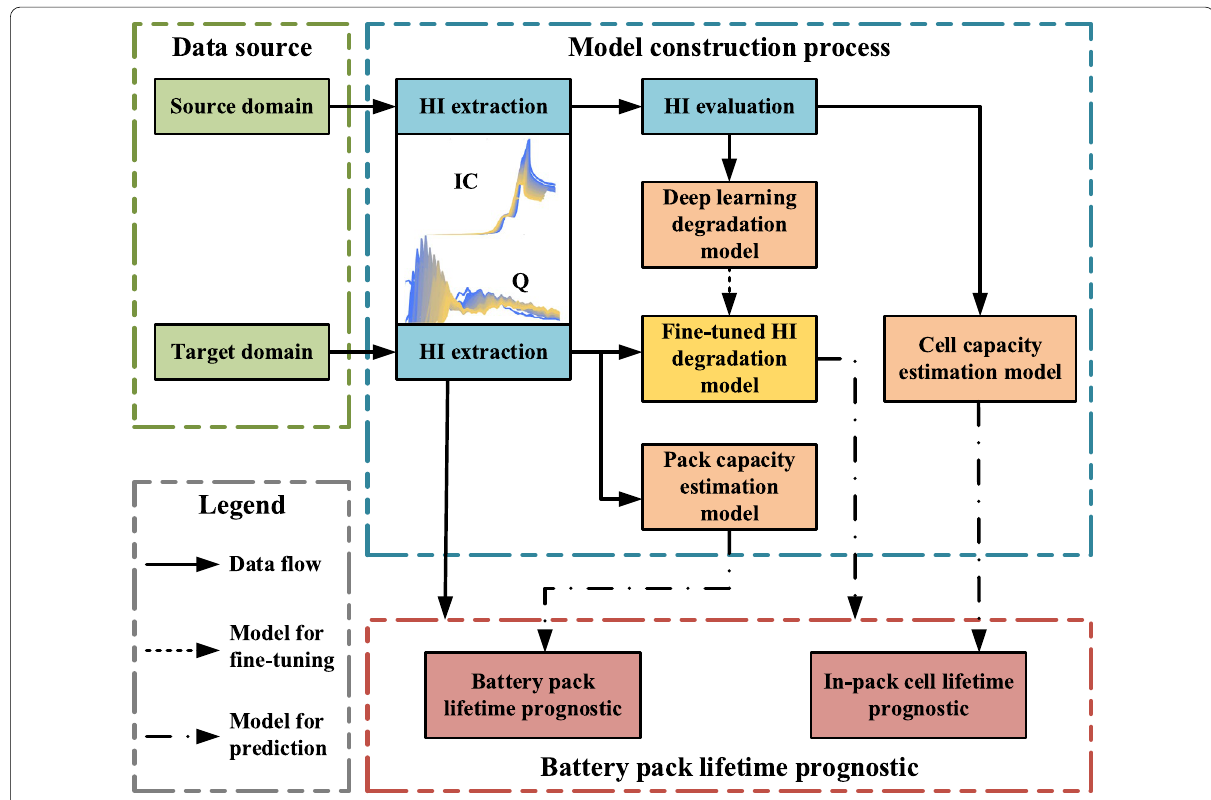
Figure 5 Battery pack lifetime prognostic